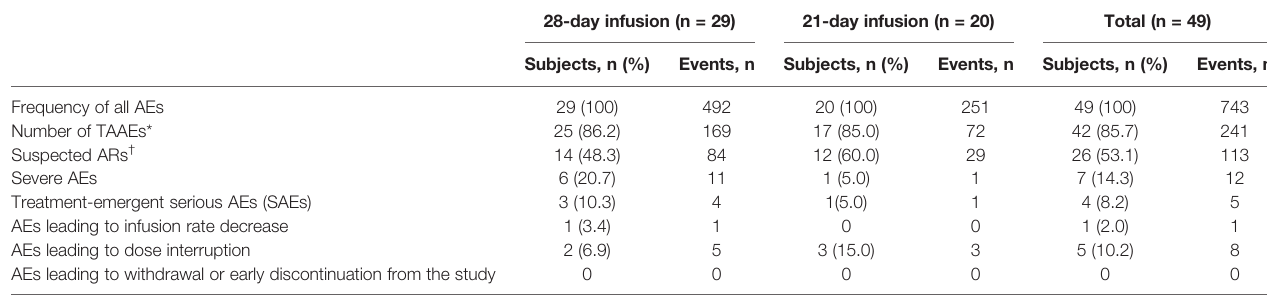
TABLE 8 | Summary of adverse events, ITT